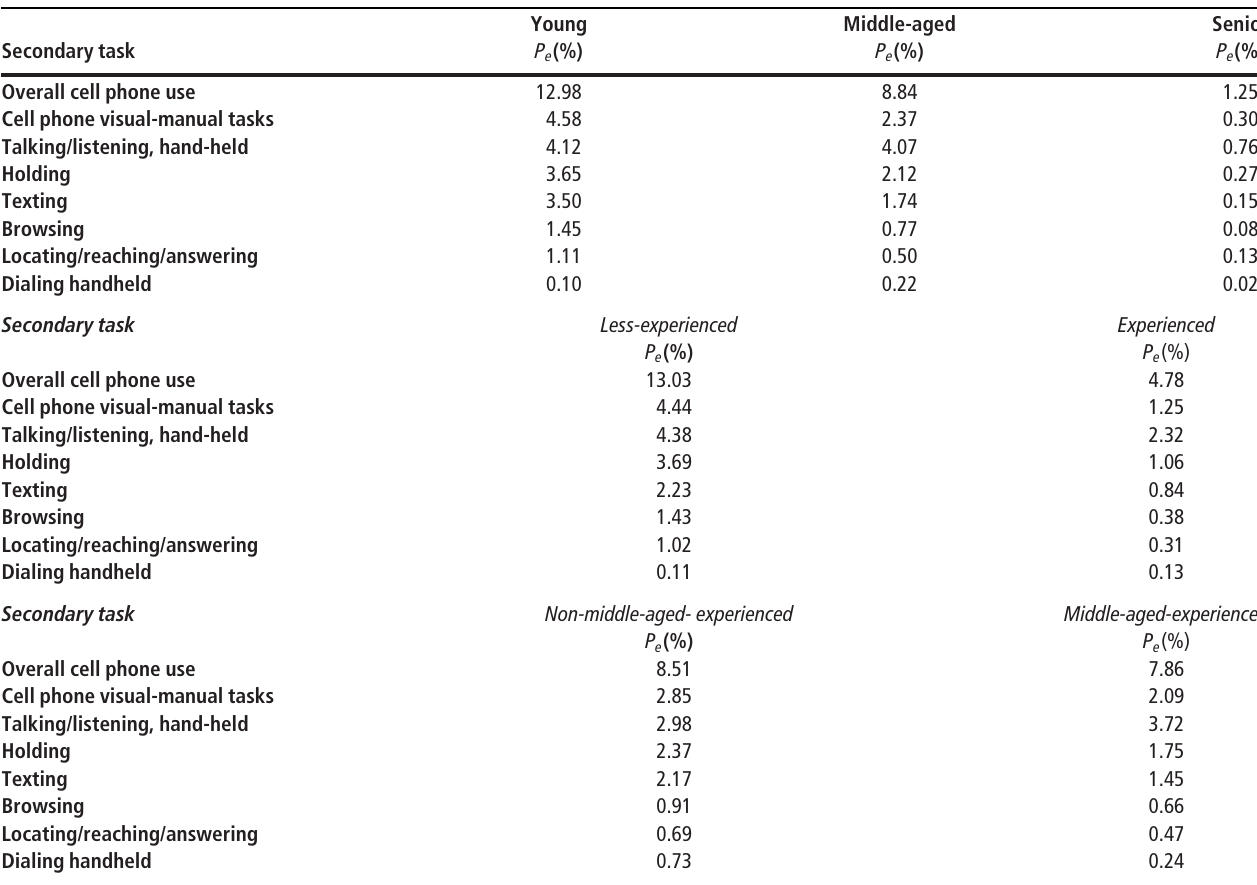
Table V Prevalence of the cell phone usage by different driver